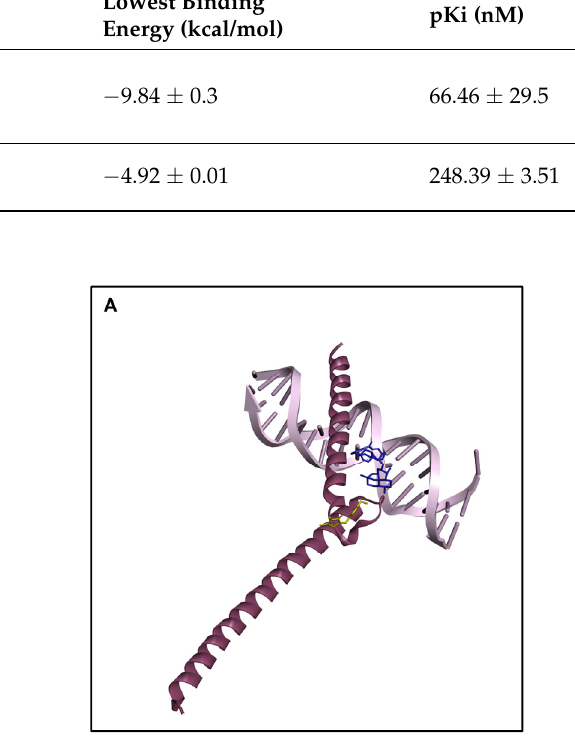
Table 3. Molecular docking results showing lowest binding energies, predicted inhibition constants, and amino acid interactions for artemisinin dimer isoniazide (ELI-XXIIID-98-2) and the known c-MYC inhibitor 10058-F4 (positive control).